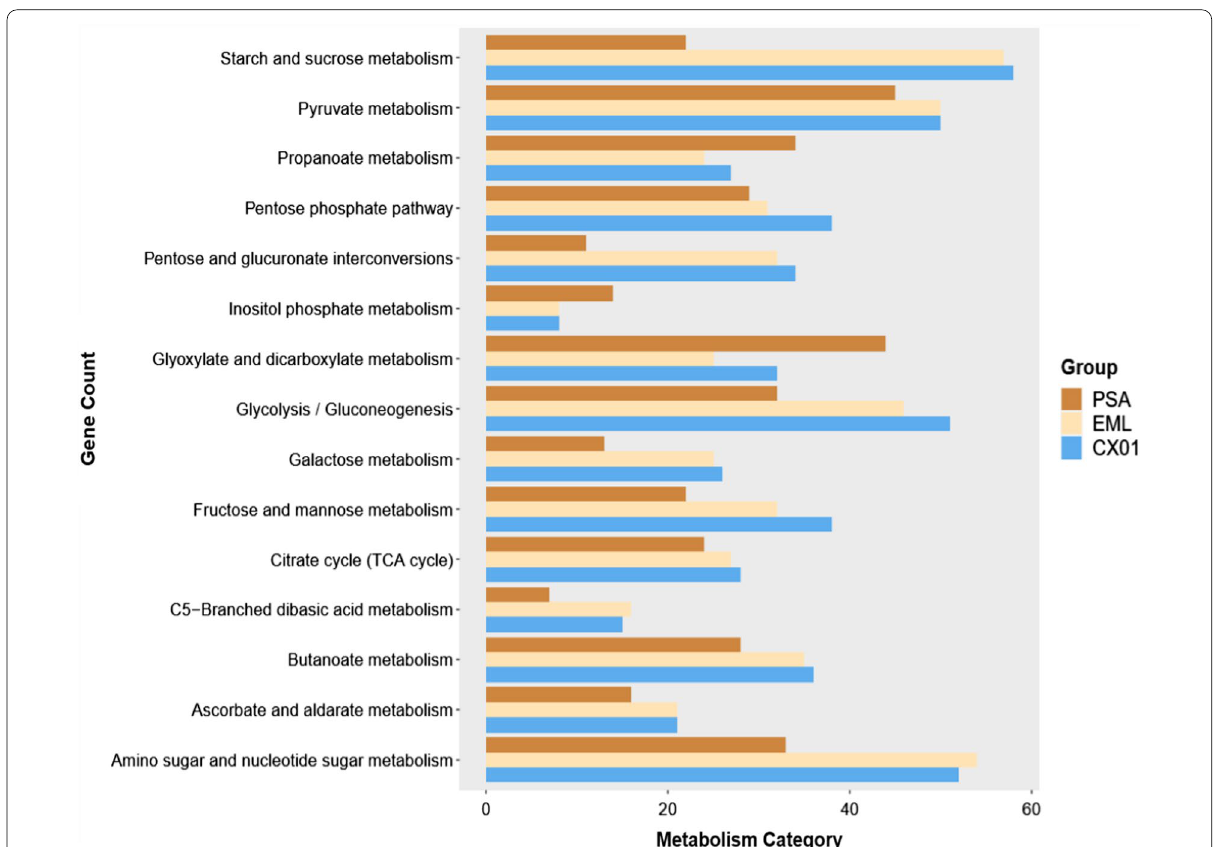
Fig. 6 Functional KEGG metabolism pathway classification of predicted genes. The columns represent gene counts in E. mori LMG 25706 (EML) , E. mori CX01 (CX01) and Psa